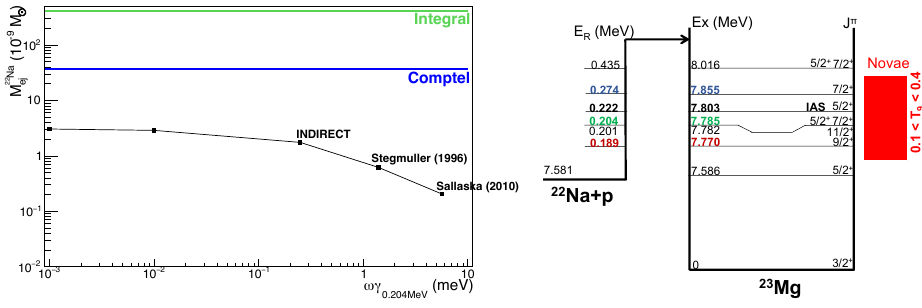
Figure 1. Left: The expected 22 Na mass ejected from a nova is given as a function of the strength of the E R = 0.204 MeV resonance, from simulations with the MESA code [5]. Colored lines mark the Integral and Comptel space telescope lower sensitivity limits. Right: Levels scheme of 23 Mg and resonance energies E R of the proton capture reaction. The Gamow window of novae is shown with the red zone.